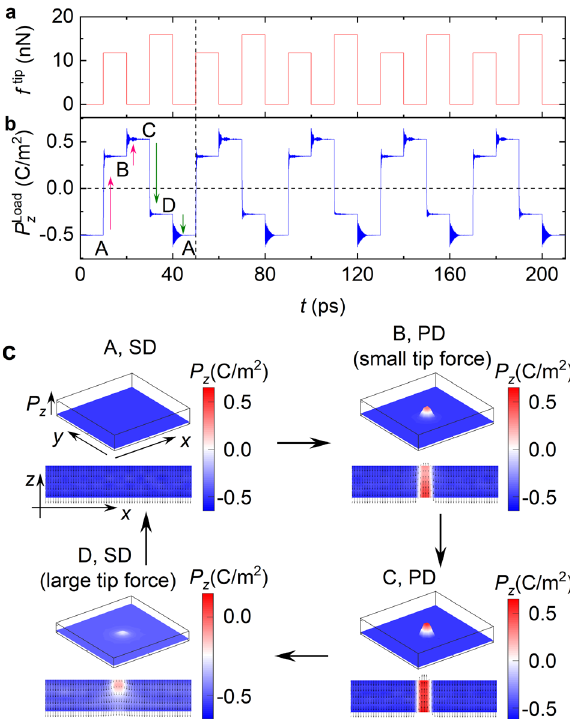
Fig. 5 Bidirectional mechanical switching via MD simulations. a Tip force pulses with alternatively varying strength applied to a BTO thin fi lm. b Evolution of the polarization of the loading area in the BTO thin fi lm under the tip force pulses. c Corresponding dipole structures during the bidirectional mechanical